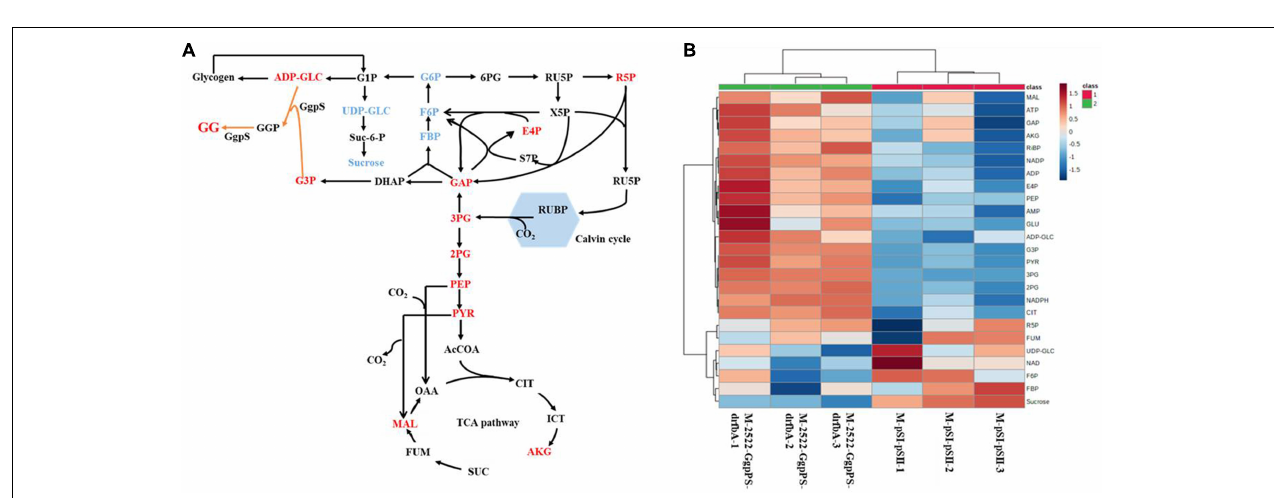
FIGURE 5 | Targeted metabolomics analysis of strain M-2522-GgpPS-drfbA and M-pSI-pSII. (A) Comparison of the metabolites in central metabolic pathway between strain M-2522-GgpPS-drfbA and the control strain M-pSI-pSII, red: increased, blue: decreased; (B) heatmaps of metabolomics profiles in strains M-2522-GgpPS-drfbA and M-pSI-pSII. Each colored cell on the heatmap corresponds to a concentration value. The higher the concentration, the darker the color (red represents the increase, and blue represents the